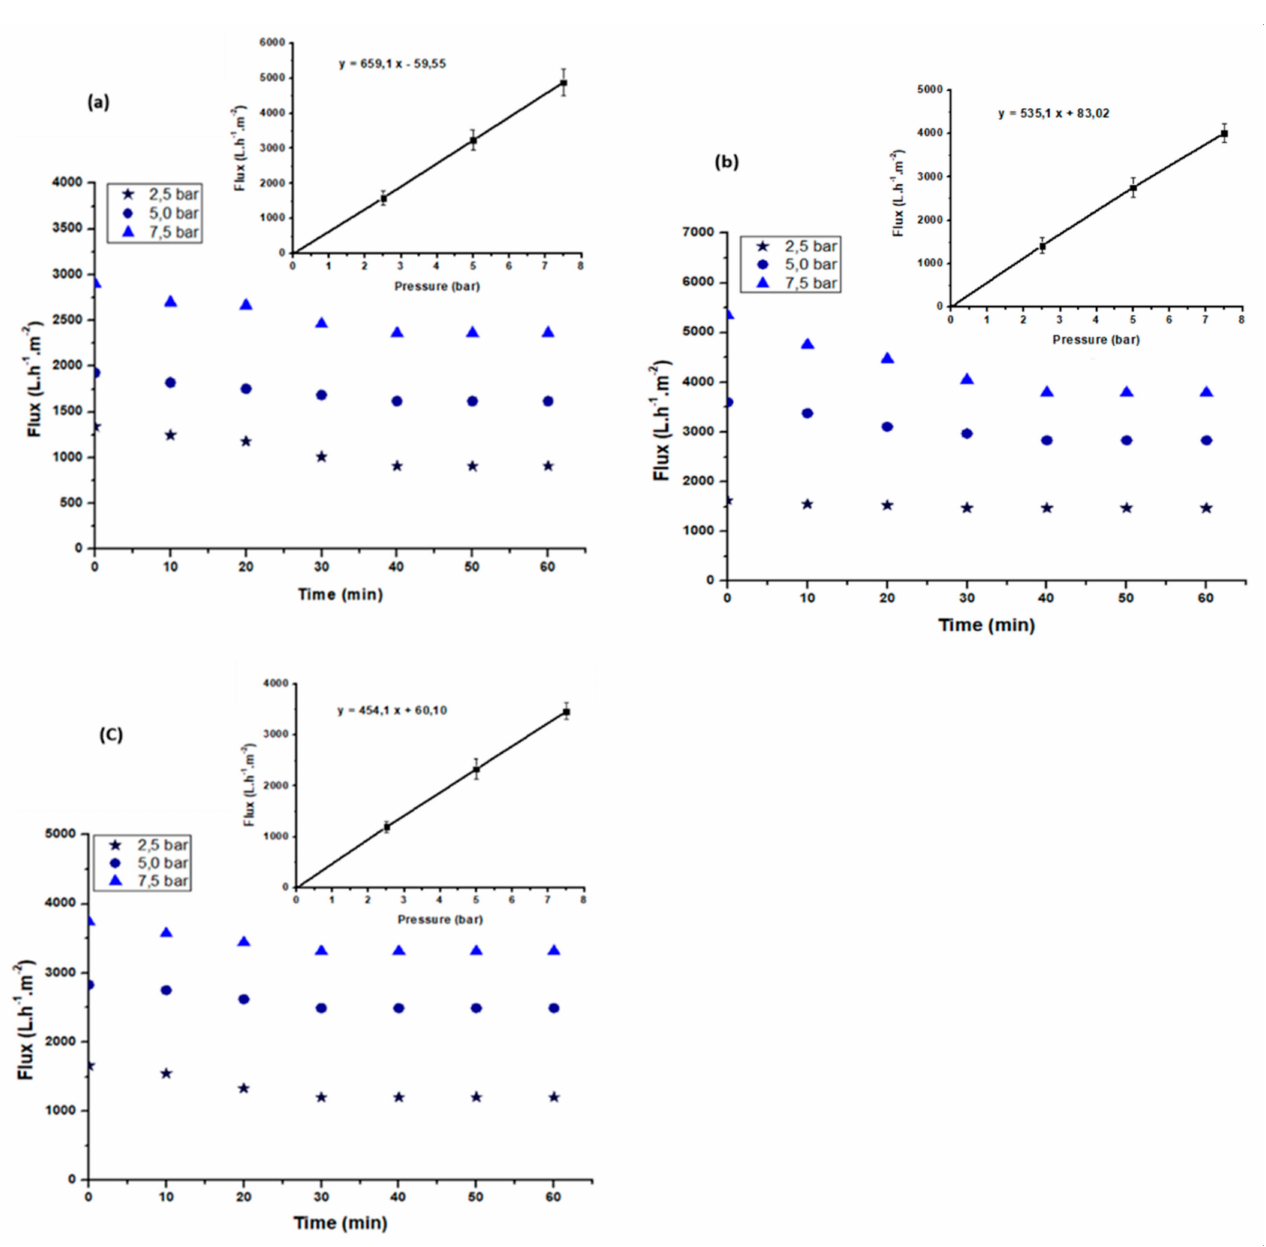
Figure 9. Variation of the permeate flux of the textile effluent with time at different pressures for the A85 ( a ), A50 ( b ), and A40 ( c )